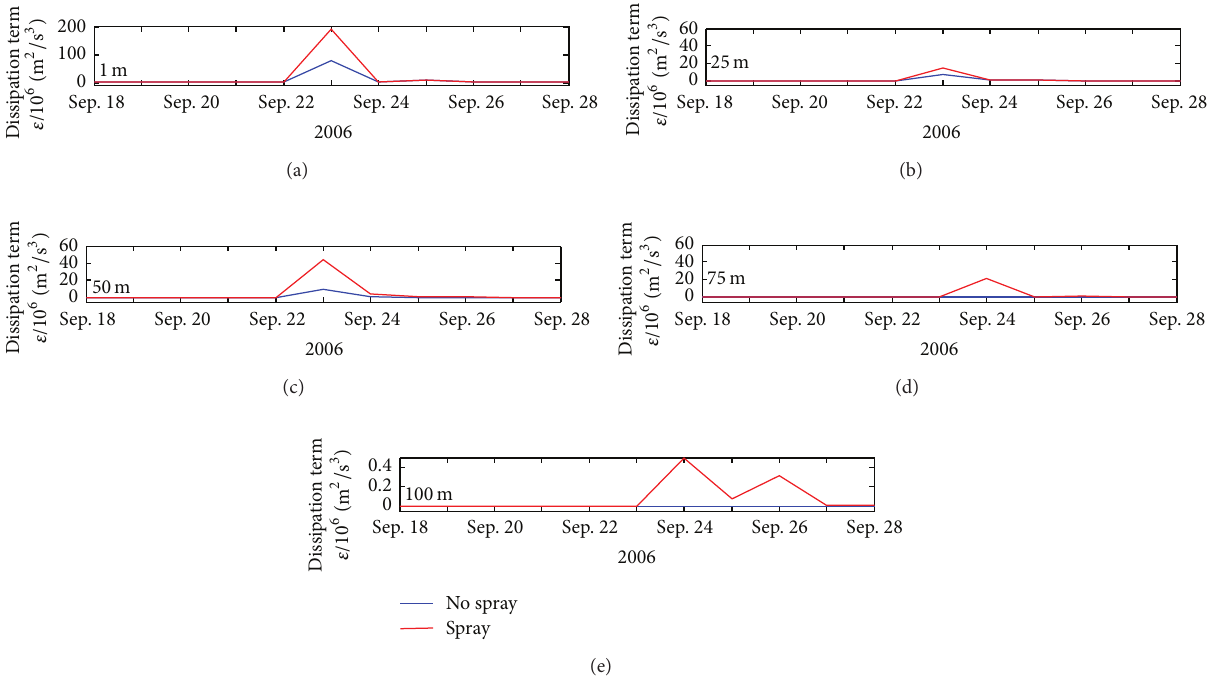
Figure 12: The same as Figure 11, but for the dissipation term 𝜀